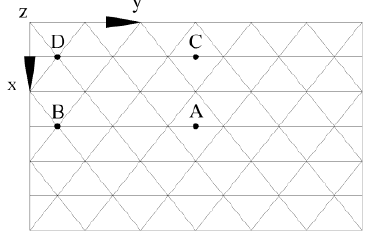
Figure 11. Part of the measurement points.